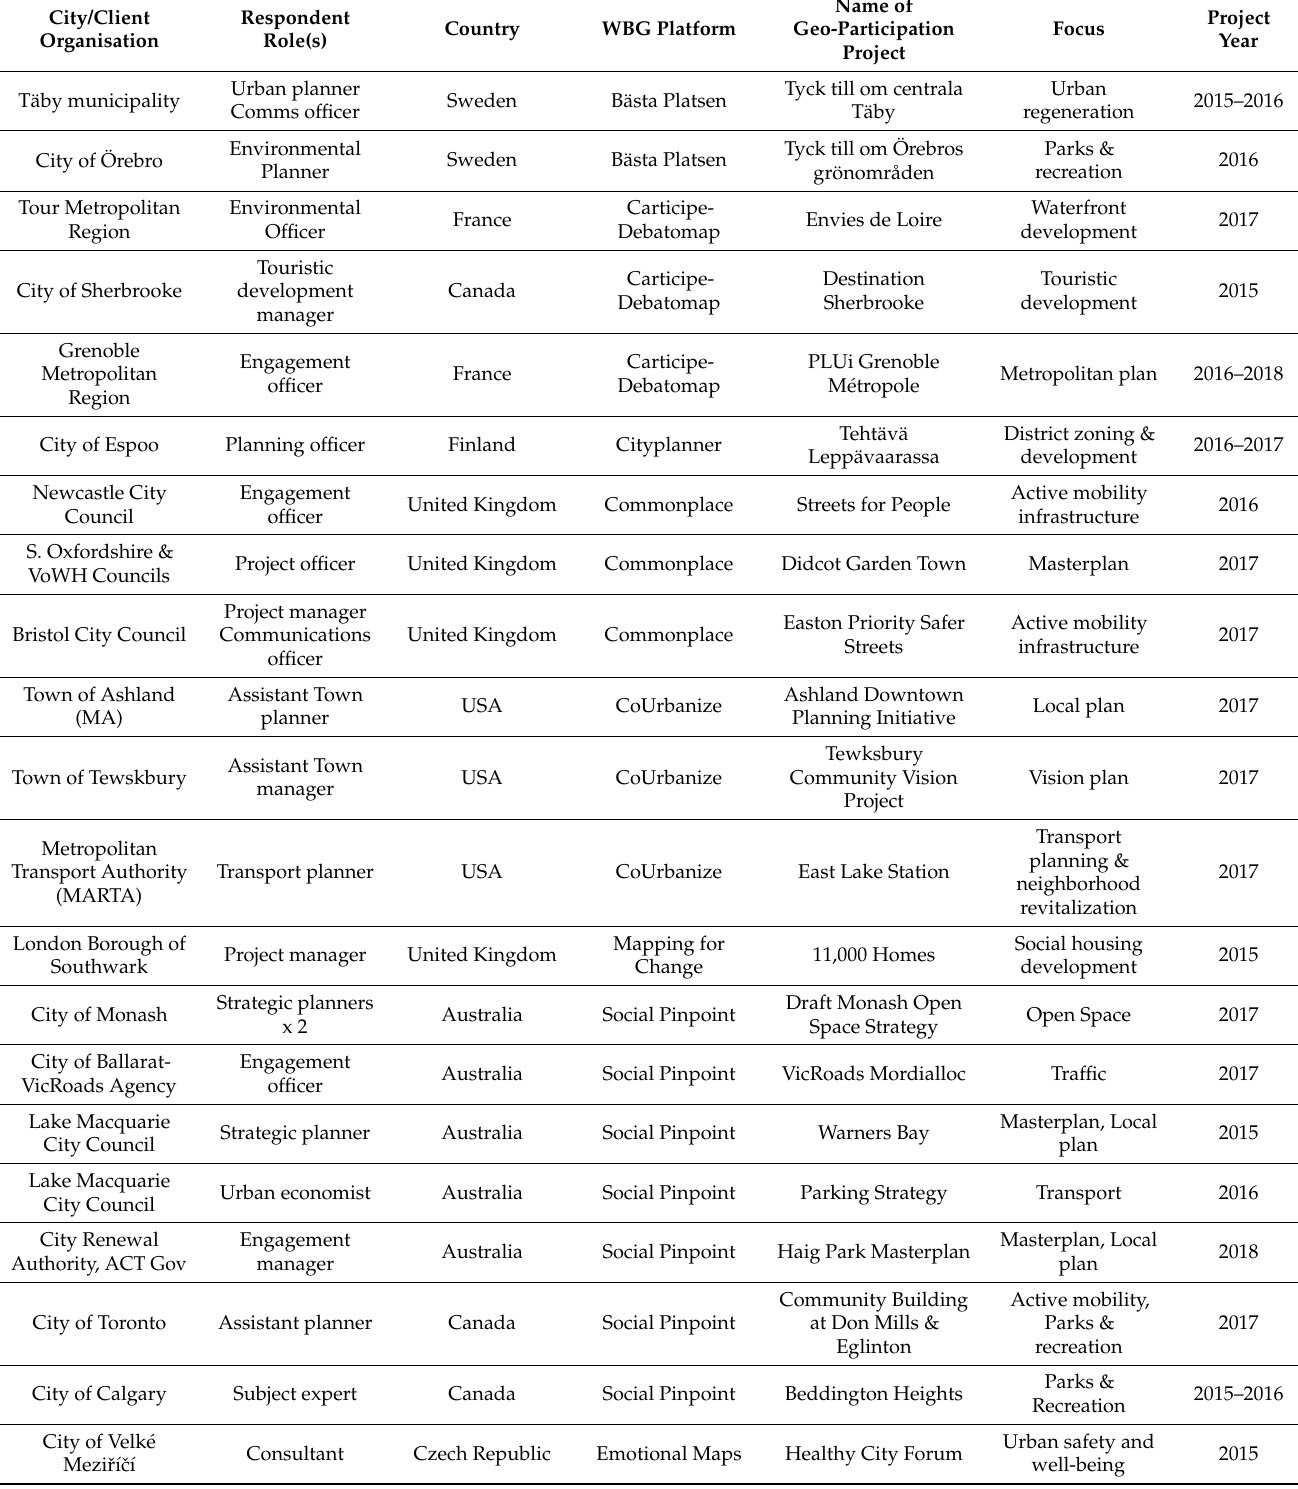
Table 1. List of the 25 reviewed web-based geoparticipation